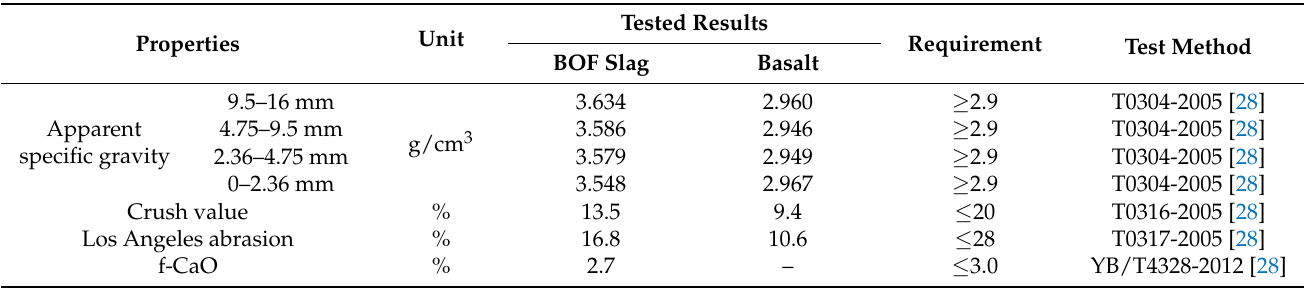
Table 2. Characteristics of aggregates in the asphalt